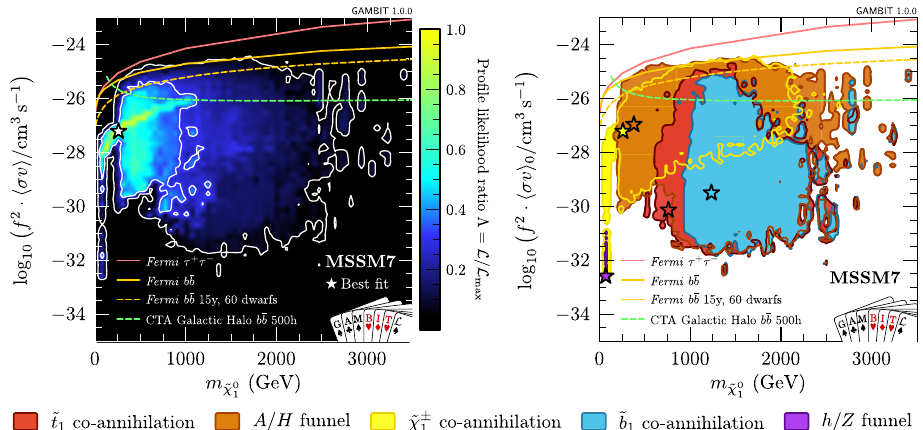
Fig. 14 Zero-velocityneutralinoself-annihilationcross-sectionsinthe MSSM7, rescaled by the square of the fraction f of the observed relic density predicted by each model. Left: profile likelihood, showing 68 and 95% CL contours. Right: mechanism(s) that allow models within the 95% CL region of the profile likelihood to avoid exceeding the observed relic density of DM. Overplotted are 95% CL constraints from the search for dark matter annihilation in 15 dwarf spheroidal galaxies bythe Fermi -LATCollaboration[183].Theselimitsarebasedon6years